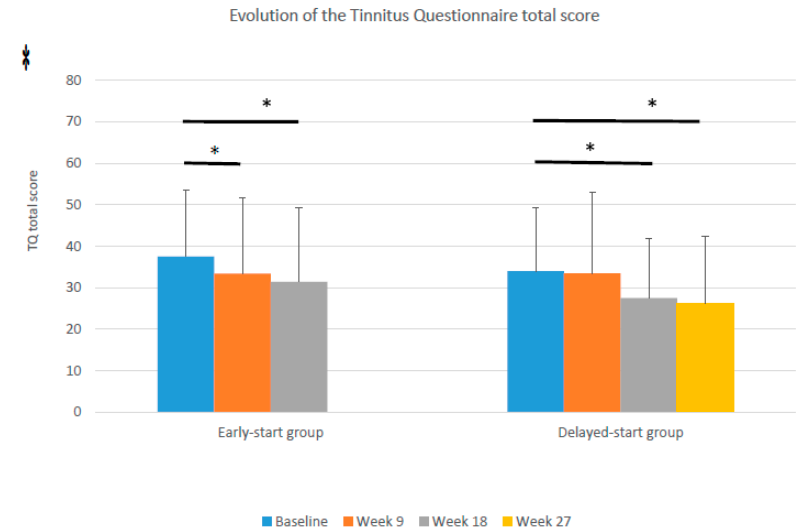
Figure 2. Evolution of the tinnitus questionnaire (TQ) scores in the early start and delayed start groups (error bars show the standard deviations, * p < 0.05).